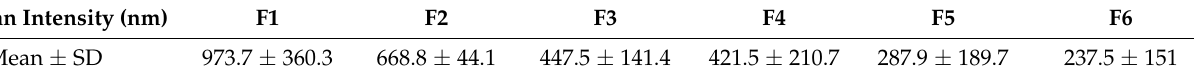
Table 2. Particle size distribution of the self-assembled liquid crystalline nanoparticles.